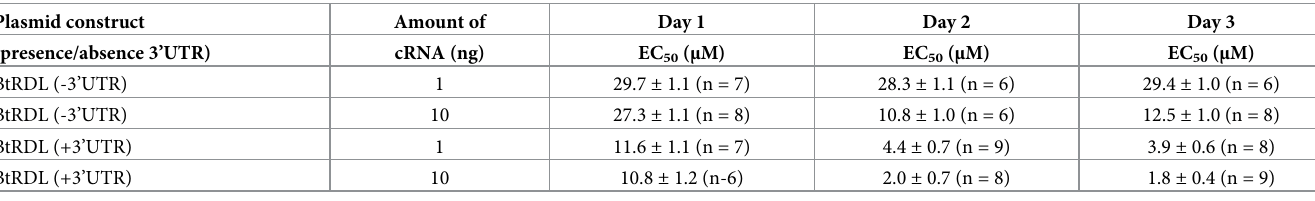
Table 1. Heterologous expression conditions and agonist (GABA) apparent affinity (EC 50 ). Plasmid